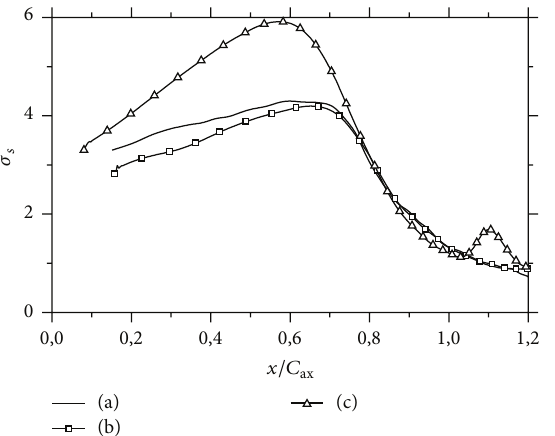
Figure 6: Time averaged magnitude of the strain tensor eigenvalue along line 𝑃 versus the axial coordinate in the blade vane: (a) LES: Re = 5.18 × 10 4 , (b) DNS: Re = 5.18 × 10 4 , and (c) LES: Re = 1.48 × 10 5 .